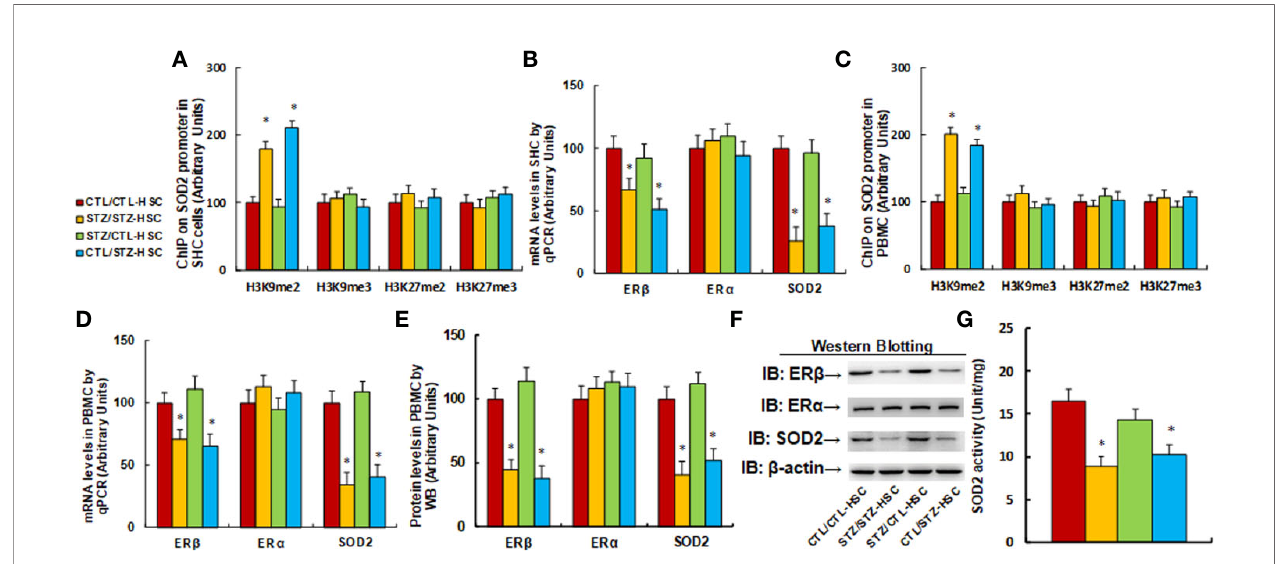
FIGURE 2 | |Transplantation of bone marrow HSC reverses maternal diabetes-induced gene suppression in PBMC in autistic offspring. The 6-week-old male offspring from either the control (CTL) or maternal diabetes (STZ) group received transplantation of bone marrow HSC from either the control (CTL-HSC) or maternal diabetes (STZ-HSC) group, and mice were used for further biomedical analysis 5 weeks after transplantation. (A) The HSC were isolated for ChIP analysis, n = 4. (B) The mRNA levels in HSC, n = 4. (C) The PBMC were isolated for ChIP analysis, n = 4. (D) The mRNA levels in PBMC, n = 4. (E) The representative pictures of western blotting. (F) The quantitated protein levels in PBMC for (E) , n = 5. (G) SOD2 activity assay, n = 5. * P < 0.05, vs. CTL/CTL-HSC group. Data were expressed as mean ±